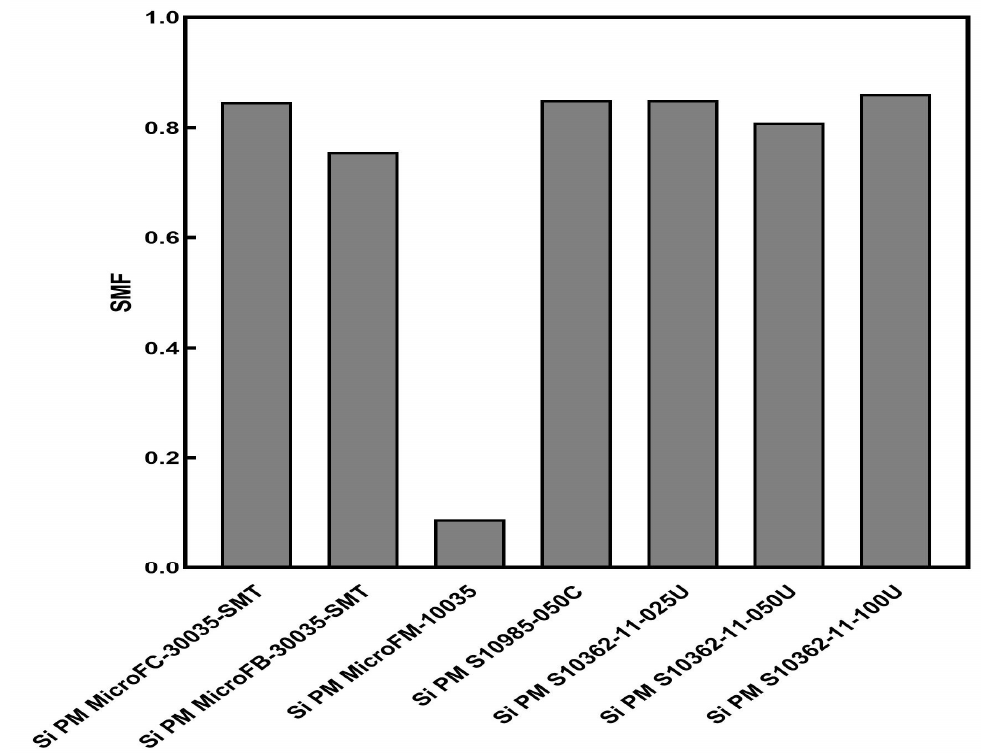
Figure 14. SMF values of LaBr 3 :Ce with various SiPMs.